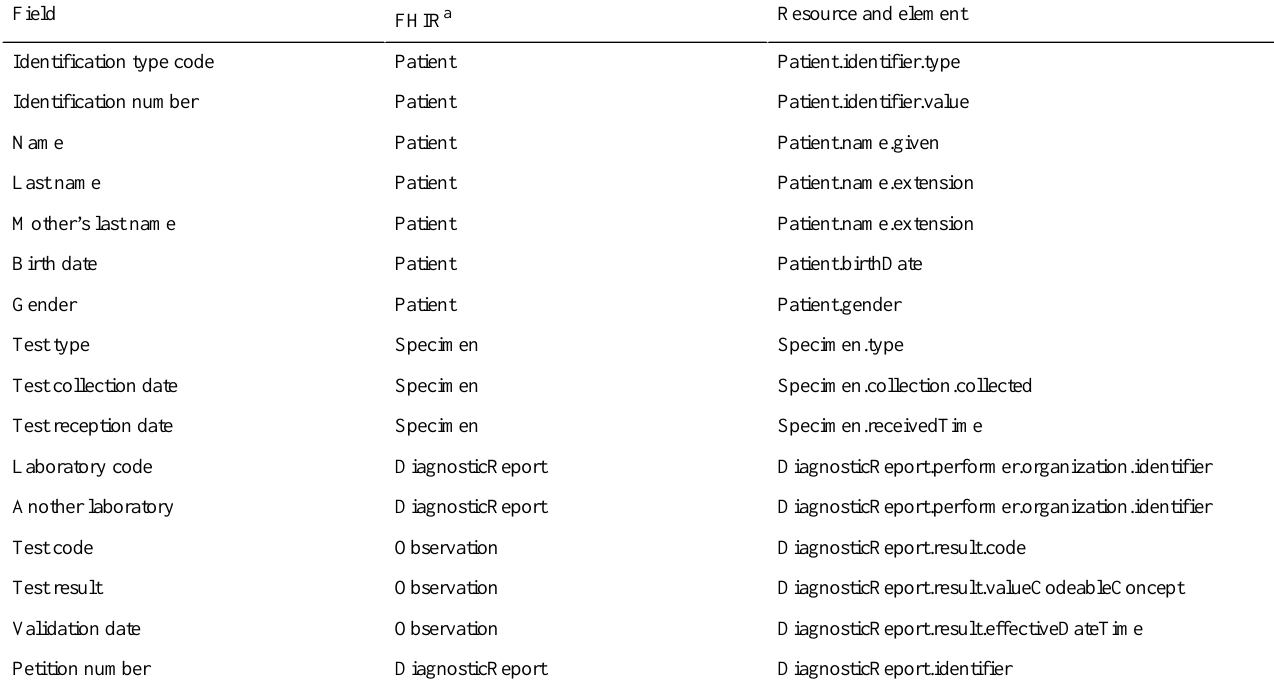
Table 2. Data set of laboratory results: the minimum data set matches each element with the FHIR.